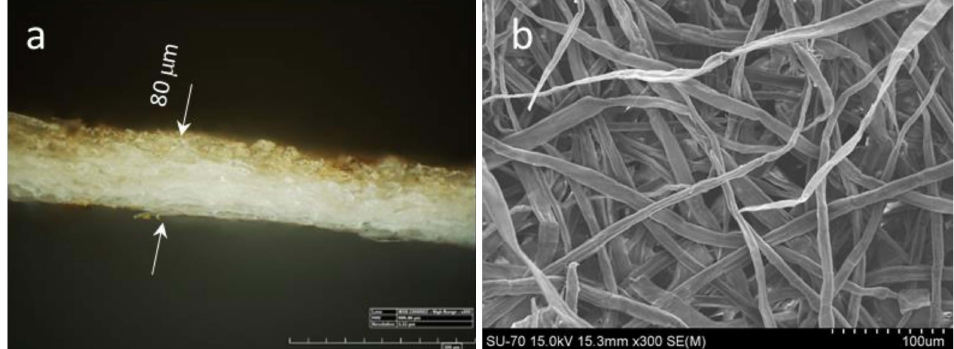
Figure 4. Cross-sectional image of the handsheet (HS) coated by CL and LS (CL + LS) obtained by optical microscopy ( a ) and the SEM image of the HS surface ( b